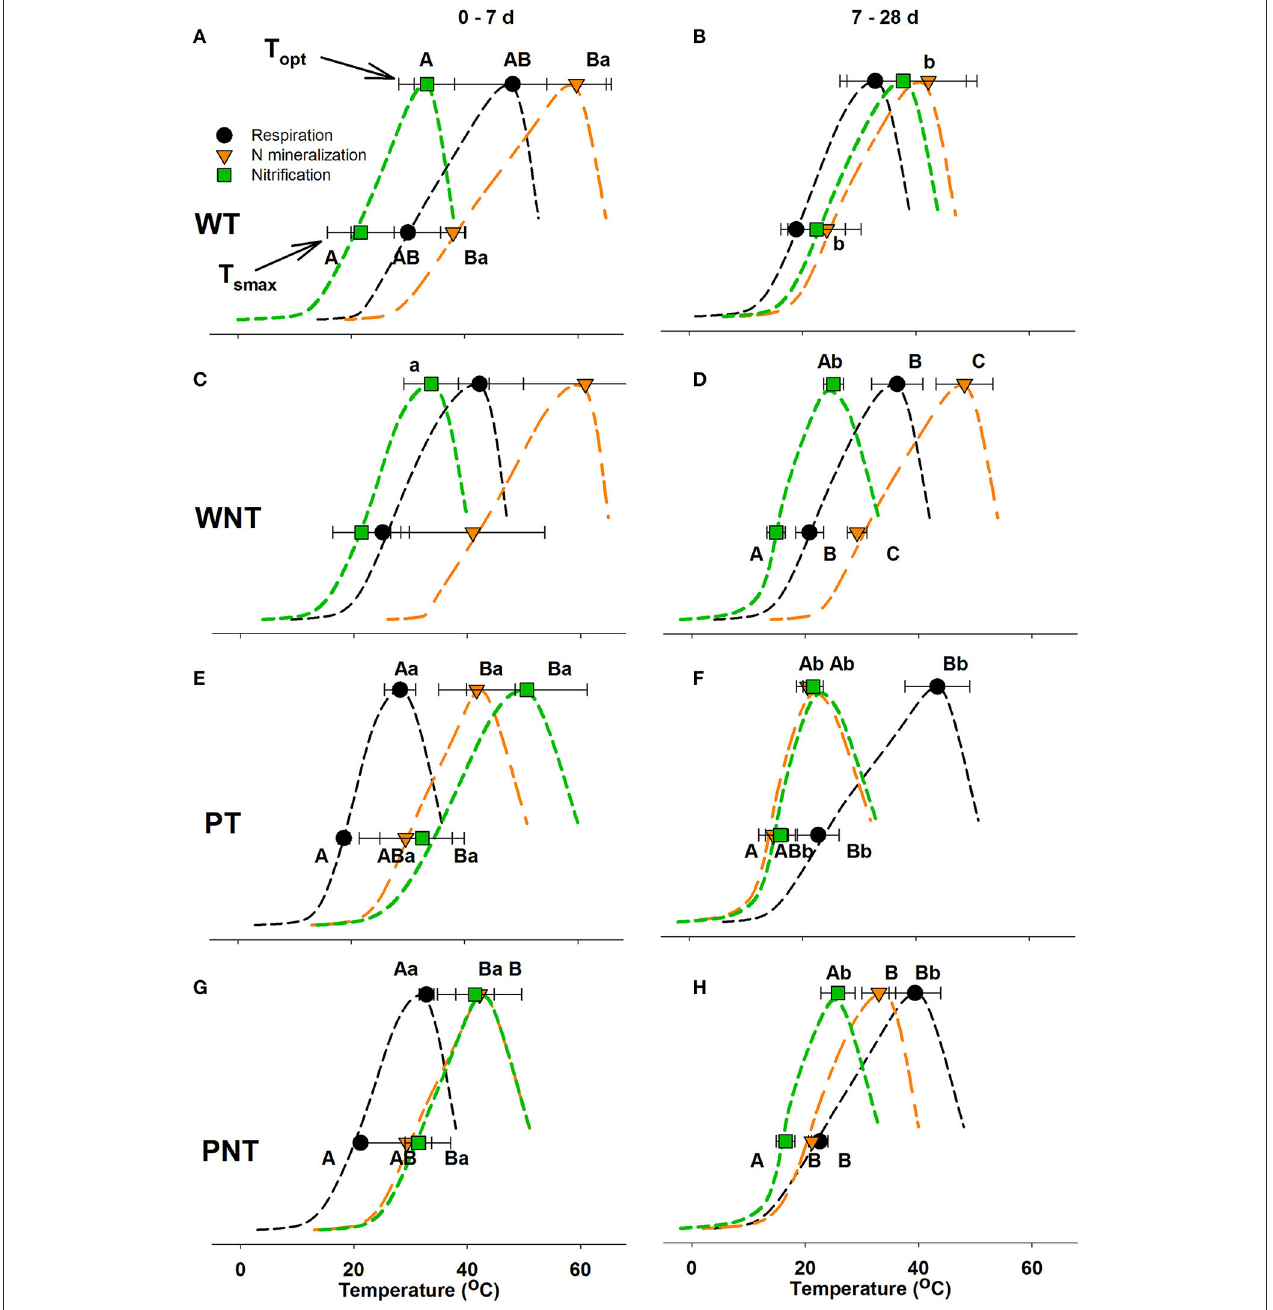
FIGURE 4 | Comparison of maximum sensitivity to temperature change (T smax ) and the optimal temperature (T opt ) of respiration, net N mineralization, and net nitrification over 0–7 d (A,C,E,G) and 7–28 d (B,D,F,H) . The symbols represent the average value of the thermodynamic parameters determined for three field replicates of each of the four sampled soils, and the error bars represent the standard deviation of the average. The dashed lines are presented to aid the visualization of the temperature response with an inflection point showing T smax and T opt . Upper case letters indicate significant differences in T smax or T opt between the three processes within a time interval; and lower-case letters indicate significant difference in T smax or T opt of an individual process between the two time periods ( p ≤ 0.05).